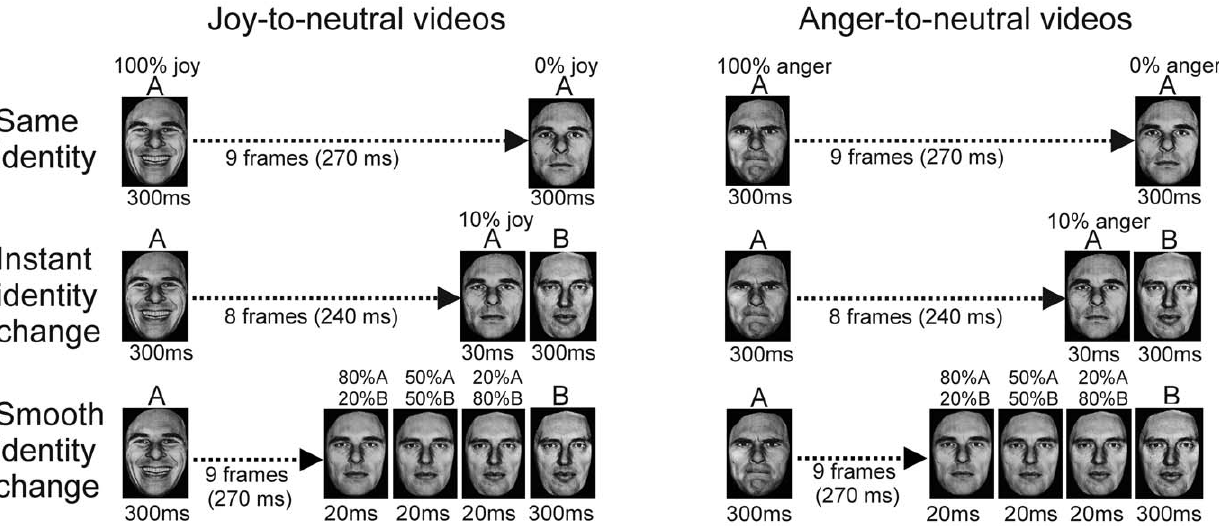
Figure 3. Illustration of the stimulus presentations in Experiment 2. Examples of the same-identity condition (top), the instant identity- change condition (middle) and the smooth identity-change condition (bottom), are given for joy-to-neutral (left side) and anger-to-neutral (right side) perceptual histories.